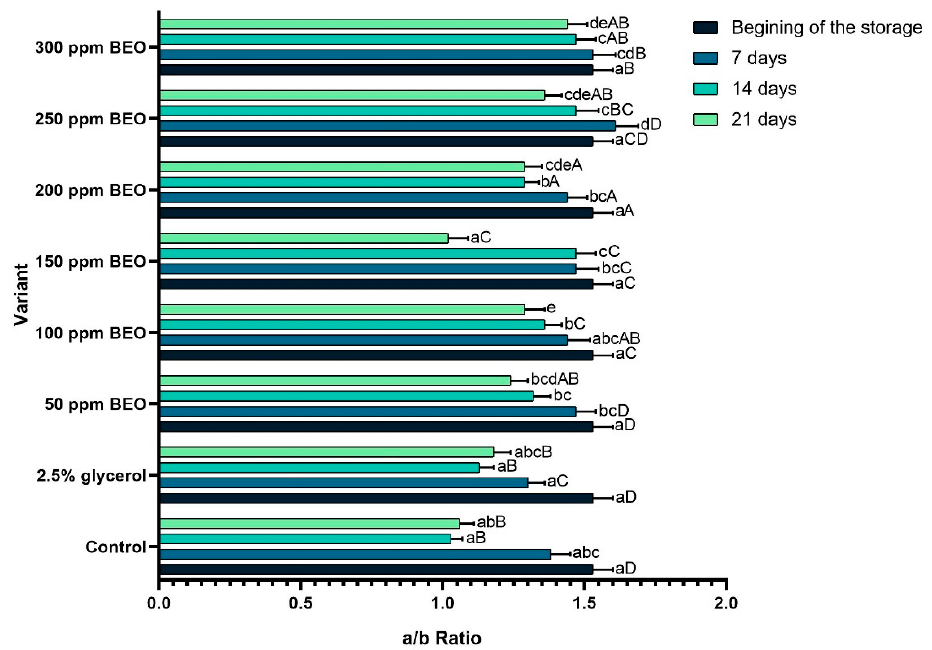
Figure 11. Effects of applied treatments on the a*/b* ratio (fruit color parameter) during storage for 21 days at 8 ± 1 °C. Bars for the same sampling time followed by different lowercase letters are significantly different based on the least significant difference (LSD) test ( p < 0.05). Bars for the same treatment during storage time followed by different uppercase letters are significantly different based on the least significant difference (LSD) test ( p < 0.05).